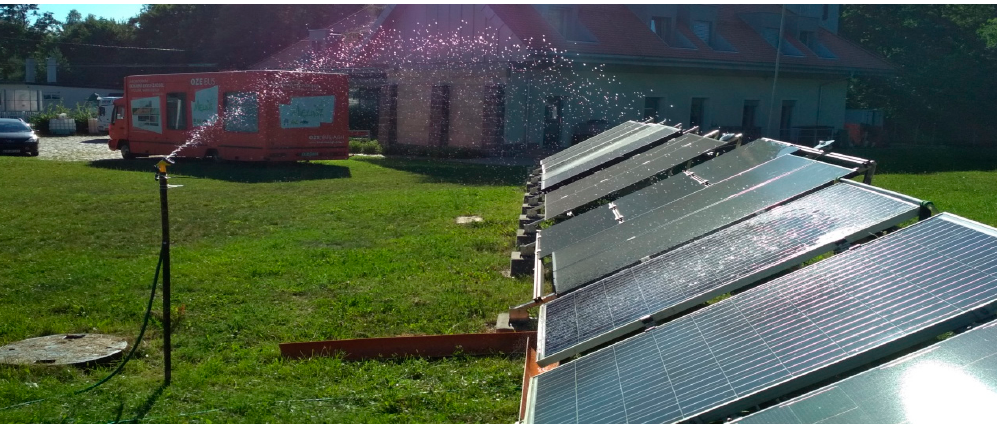
Figure 3. Research stand with cooling by means of the imitation of rain.